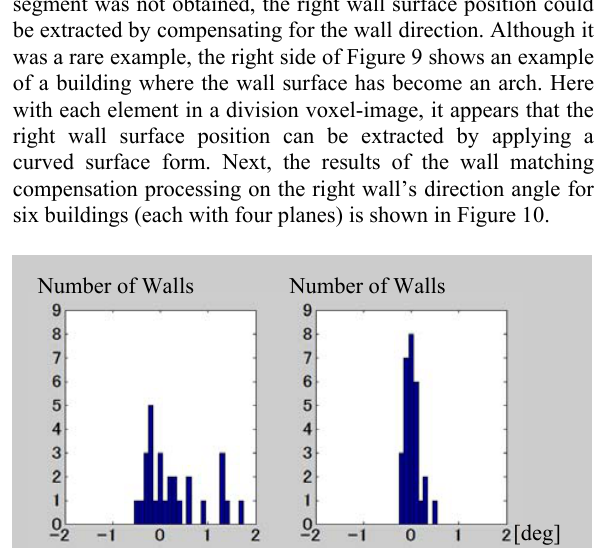
Before Figure10. Results of the Wall Direction Histogram